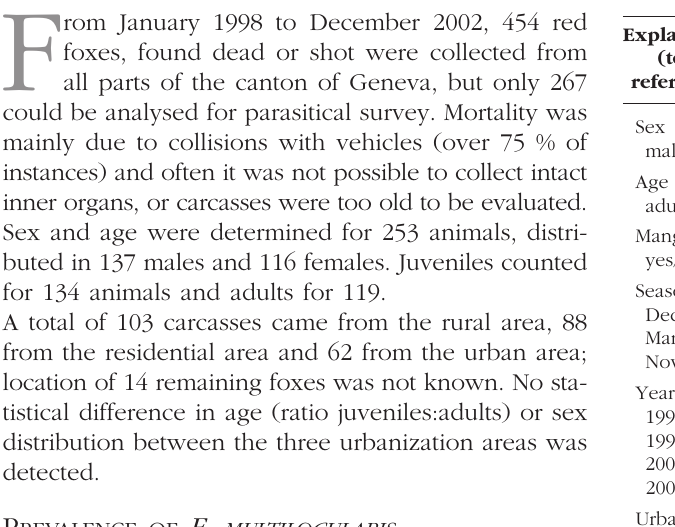
between the different urbanisation sectors (Table I). A Log-Likelihood test revealed that the addition of the factor urbanisation sector improved the model only at